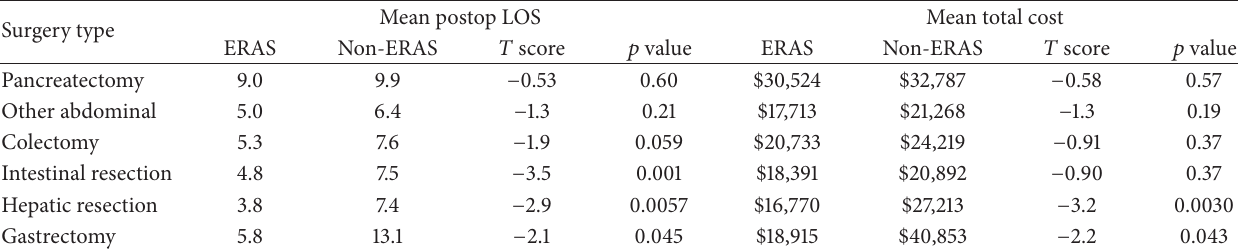
Table 6: Differences in LOS and cost by procedure type in ERAS versus non-ERAS groups, 2013–2015. Surgery